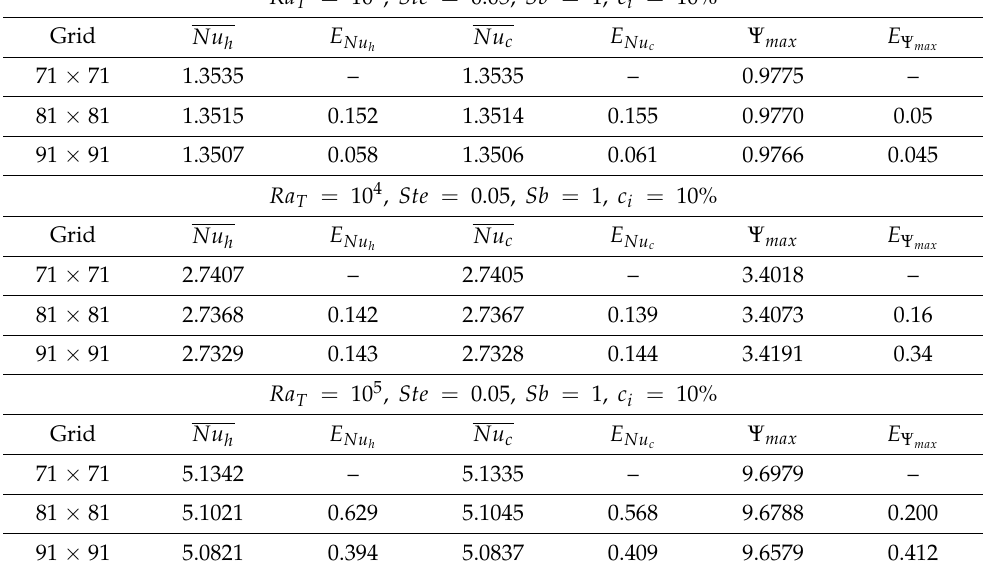
Table 1. Grid test